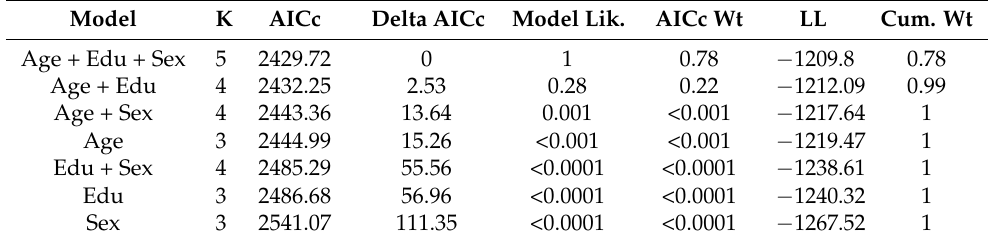
Table 4. Comparison between regression models with the best transformation of independent variables for accuracy. K = Number of parameters of the model; AICc = Akaike’s Information Criterion corrected; Delta AIC = AIC difference between the best model and the model listed; Model Lik. = the relative likelihood of the model; AICc Wt = model probabilities; LL = log-likelihood of the model; Cum. Wt = cumulative Akaike weights.